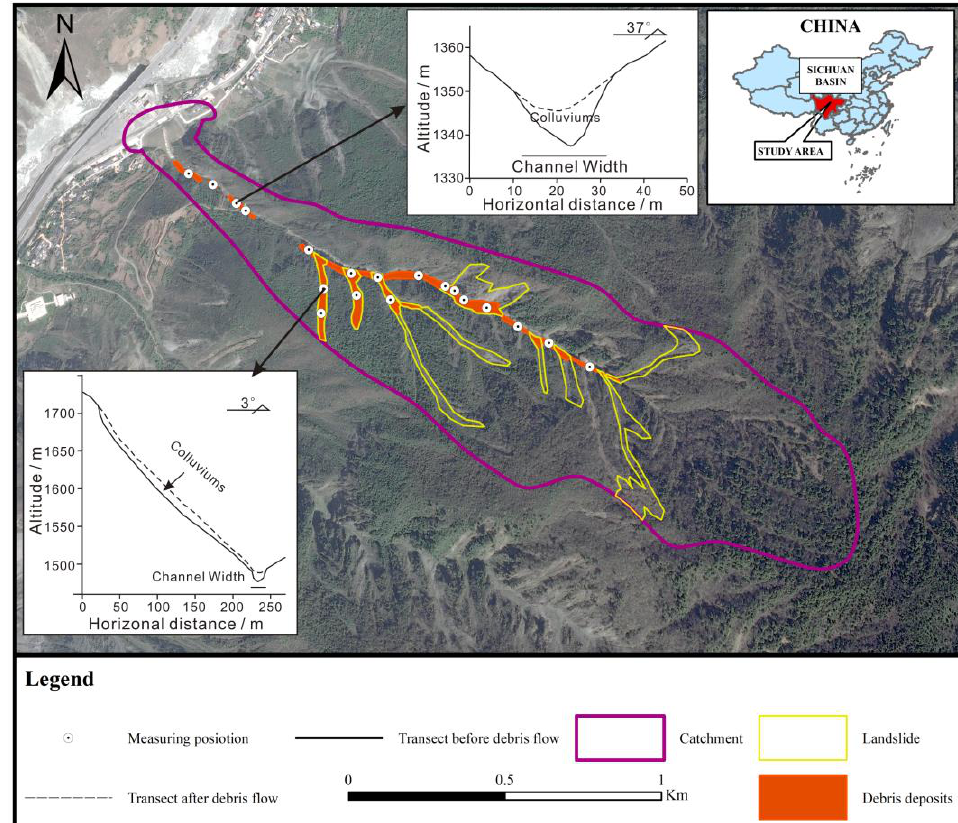
Figure 1. Overview of the study area. The landslides and deposits along the channel were identified on a satellite image from 15 April 2015.